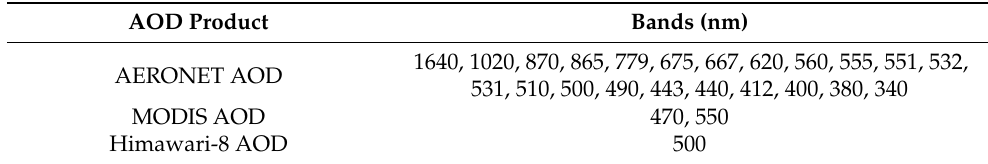
Table 1. List of AOD products at different wavelengths.